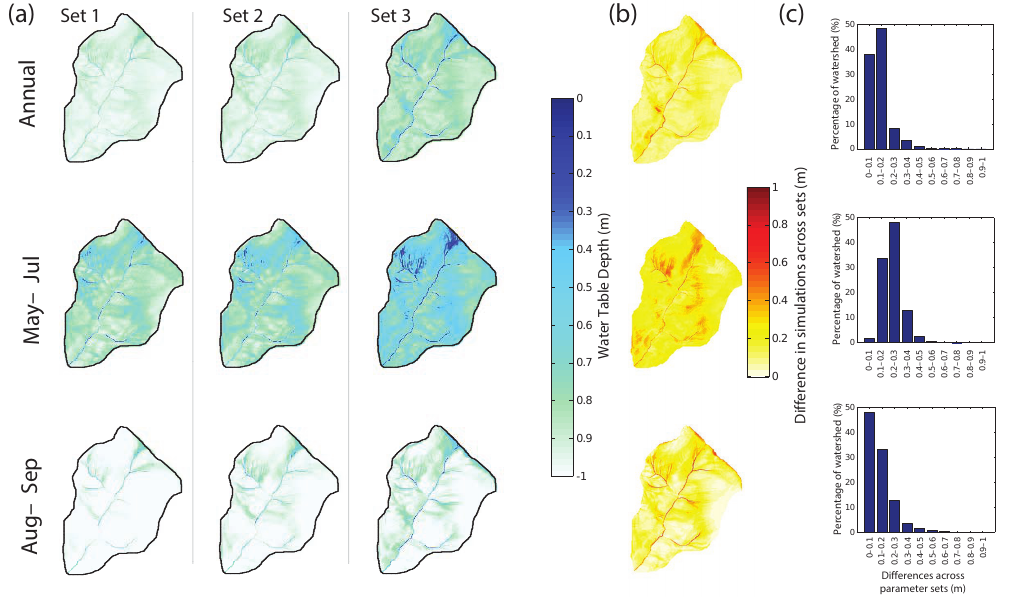
Figure 9. Predictions of annual, May–July, and August–September water table depths (a) in space, across the watershed (for a subset of three parameter sets (1, 2, and 3) corresponding to sets 1, 5, and 9 in Fig. B3), (b) shown as differences in space across nine equifinal parameter sets, and (c) with differences on a cell-by-cell basis summarized as histograms per time period. Color on maps indicates (a) the average depth across a given period between bedrock ( − 1m) and the surface (0m) and (b) the largest difference between all nine predictions at each cell. Predictions are shown for three parameter sets that span the range of behavior from lower (set 1) to higher (set 9) water table conditions across all nine parameter sets. Predictions of water table depth across all behavioral sets are included in Fig.